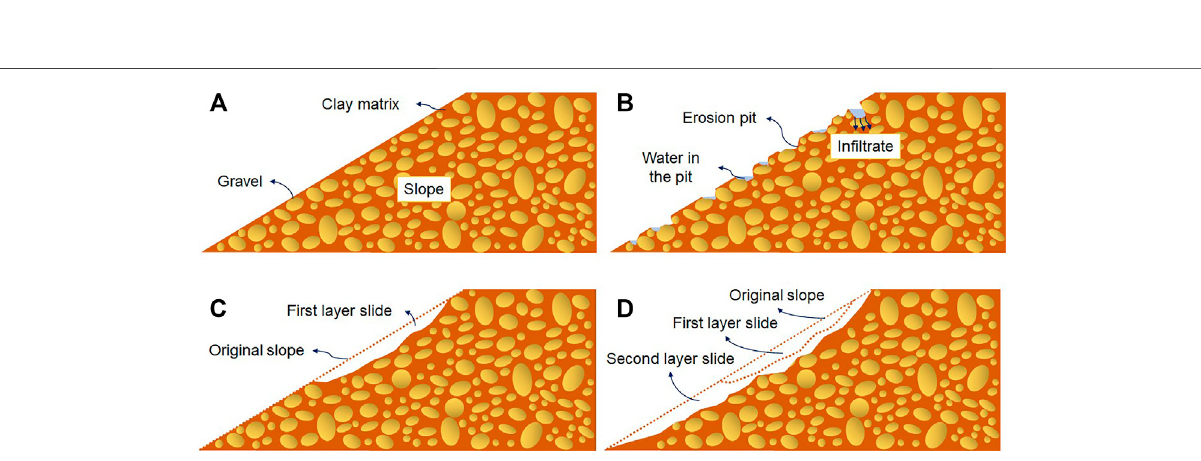
Frontiers in Earth Science |